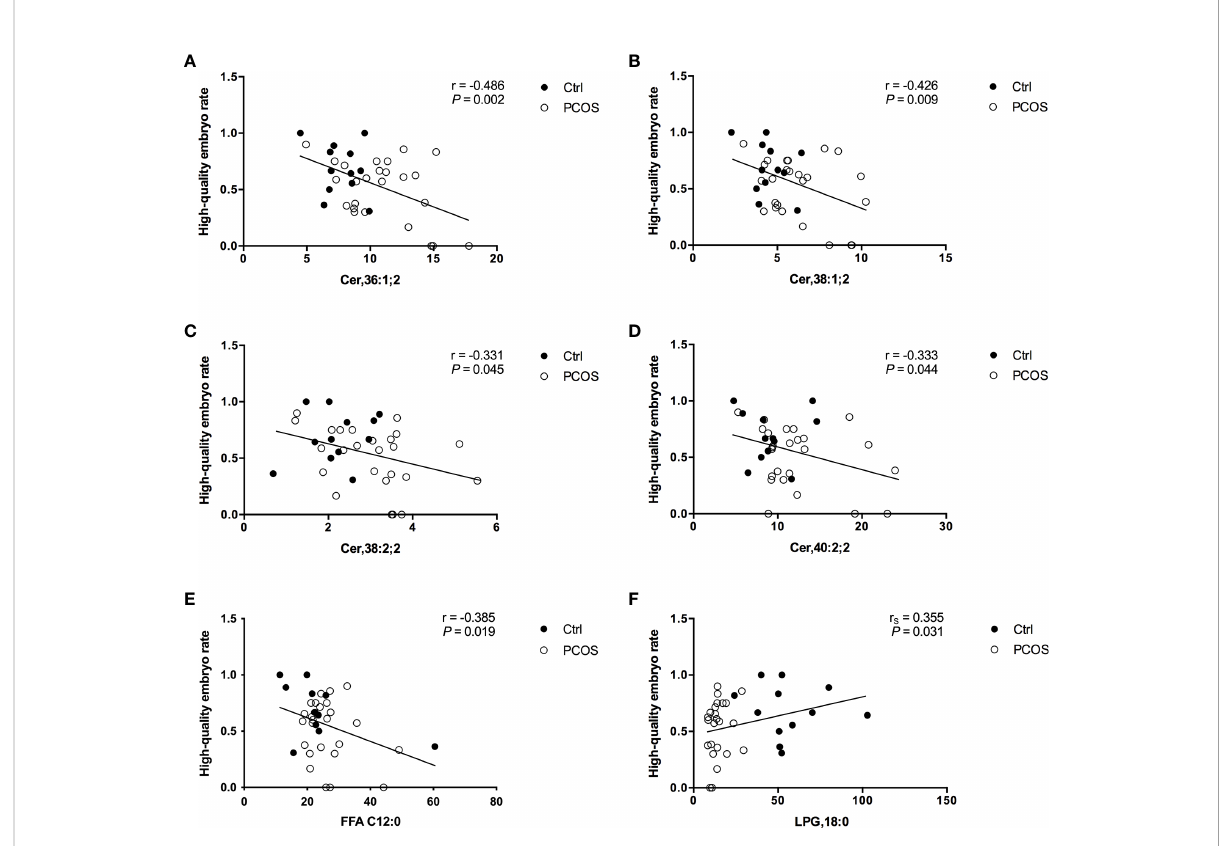
FIGURE 2 Correlation between speci fi c FF lipids and embryo quality in patients with (white dots; n = 25) and without (black dots; n = 12) PCOS. Regression analysis between HQER and Cer,36:1;2 (A) , Cer,38:1;2 (B) , Cer,38:2;2 (C) , Cer,40:0;2 (D) , FFA C12:0 (E) , and LPG,18:0 (F) respectively was performed. The lines indicate the fi tted regression